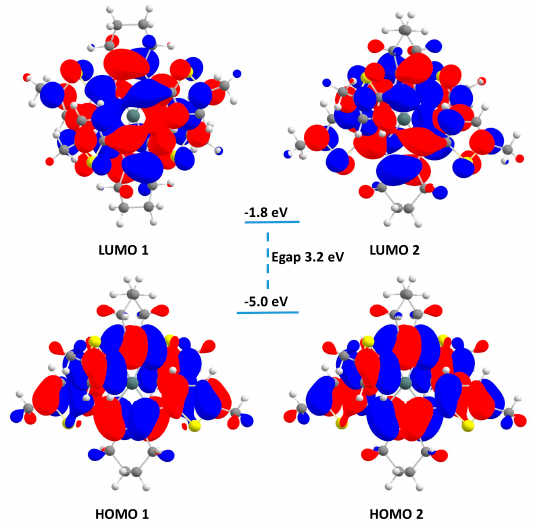
Figure 2. FMOs and HOMO-LUMO energy gap of spirostannole 4 based on DFT calculations.